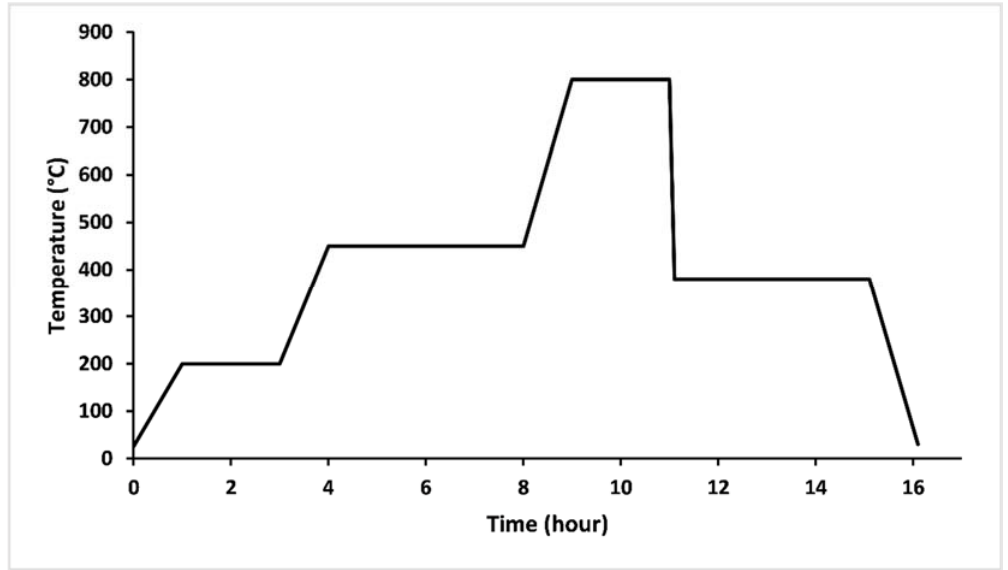
Figure 1. Thermal profile used to elaborate glasses.